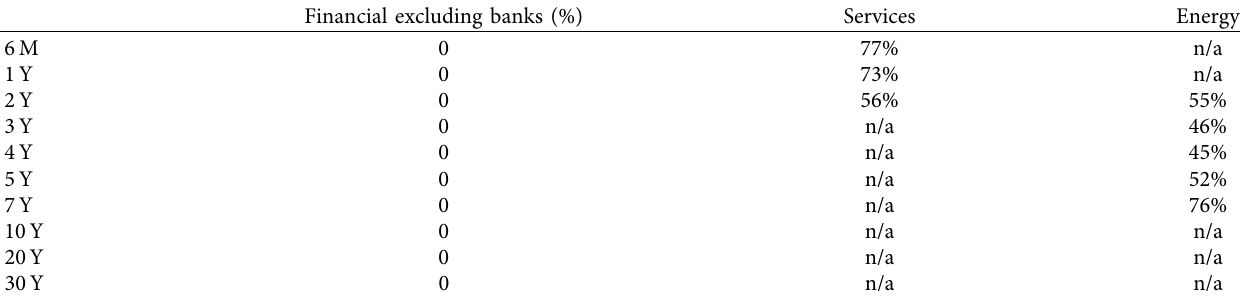
Table 3: p -values from the Chow test for the financial excluding banks, services, and energy sectors, 2015–2019. Financial excluding banks (%)